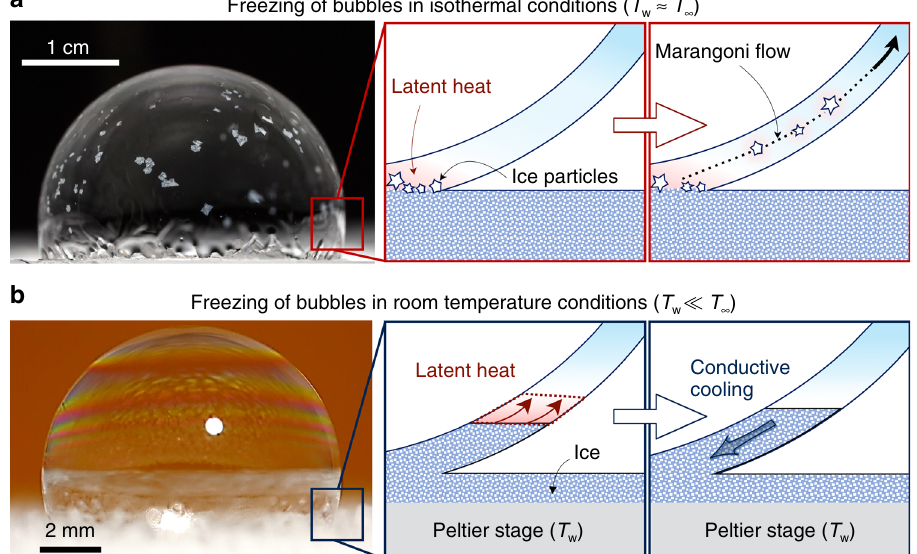
Fig. 1 The dynamics of freezing bubbles under various ambient conditions. a For bubbles deposited on an icy substrate contained within an isothermal freezer, the freeze front induced local heating at the bottom of the bubble. This resulted in a Marangoni fl ow strong enough to detach and entrain growing ice crystals, such that the bubble froze from multiple fronts. b For bubbles deposited on a chilled, icy substrate in a room-temperature environment, the freeze front grew bottom-up in a uniform fashion before stopping entirely at a critical height. Latent heat generated at the growing freeze front had to be continually dumped into the substrate via inef fi cient conduction across the frozen portion of the